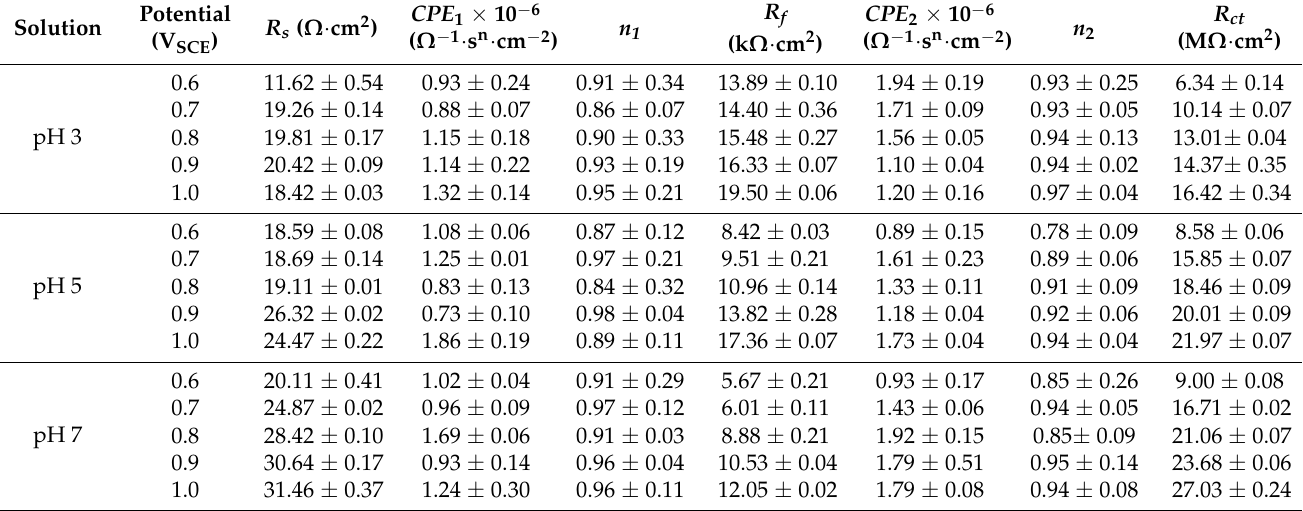
Table 2. Fitting results of EIS from Figure 4. R s is solution resistance, R f is passive film resistance, R ct is charge transfer resistance, n is the dispersion index, and CPE is a constant phase